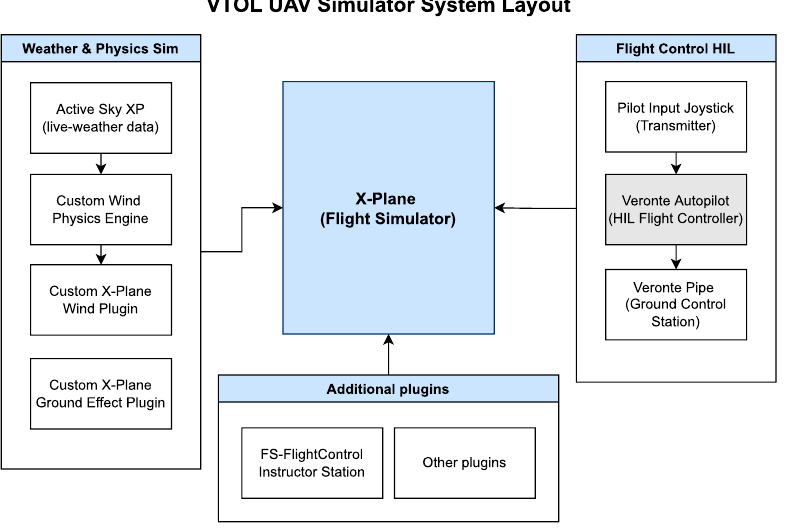
Figure 6. VTOL UAV Simulator System block diagram featuring all three subsystems connected to X-Plane.